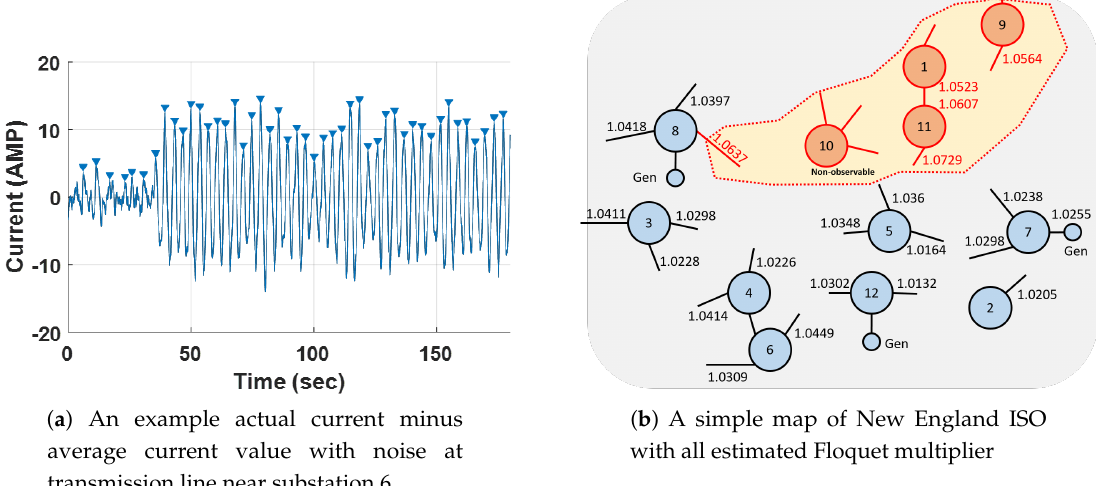
Figure 12. An estimation of Floquet multiplier at actual power system oscillation